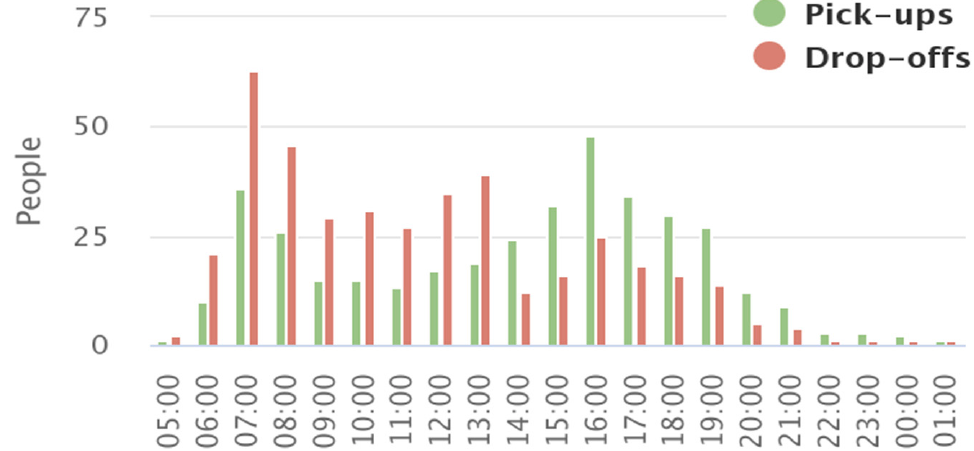
Figure 10. An example of the DORAM KPIs (pick-ups and drop-offs in each time interval) for a stop. Evidence information, it is used to support KPIs for each stop. To mention a few; (1) total daily drop-offs, pick-ups and vehicle trips, in the Stop panel (see Figure 9), (2) drop-offs, pick-ups, and vehicle trips, (for instance, see Figure 11a) for each line in each time interval, by clicking on Daily Drop-offs, Daily Pick-ups, and Daily Vehicle Trips in the Stop panel, (3) line information, by clicking on the line direction (see Figure 11b), (4) nearby services (e.g., offices, stores), by clicking on Services on the route button (see Figure 11c), passing vehicle lines and their directions.